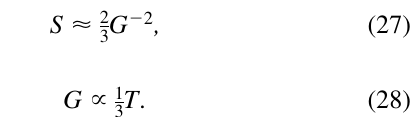
FIG. 1. The phase portrait of the system governed by Eqs. (21) and (22).